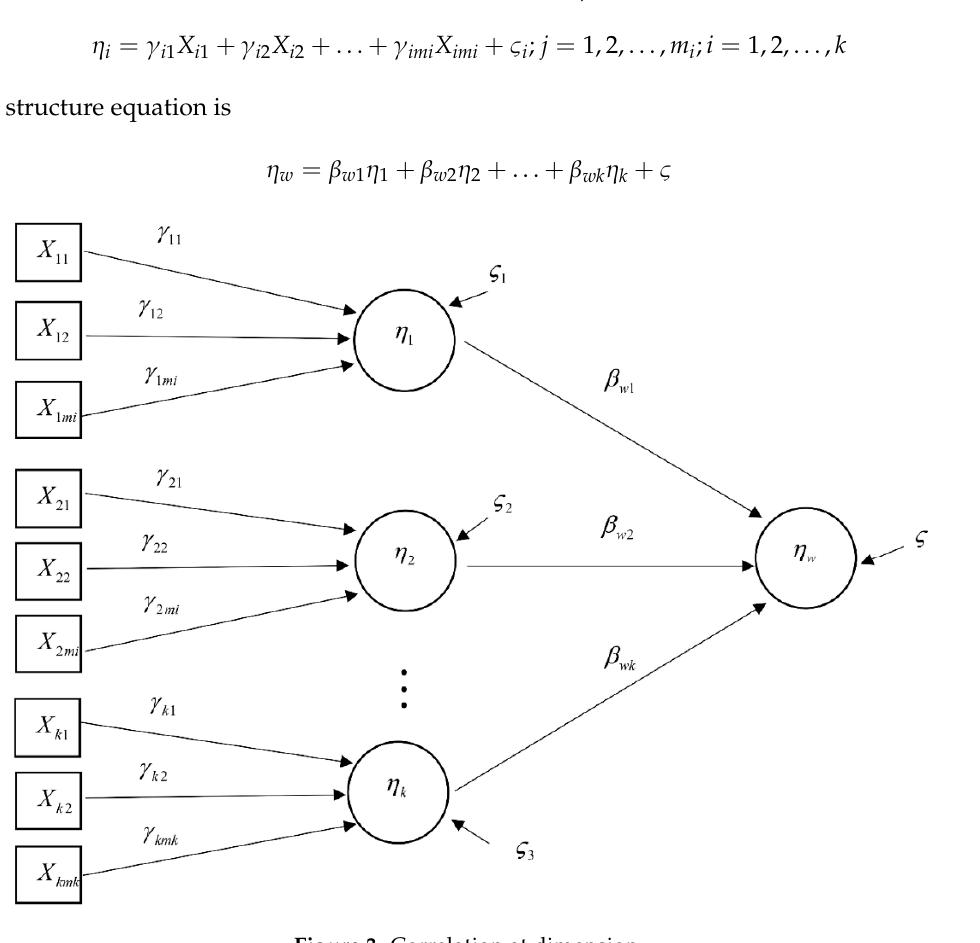
Figure 3. Correlation at dimension.